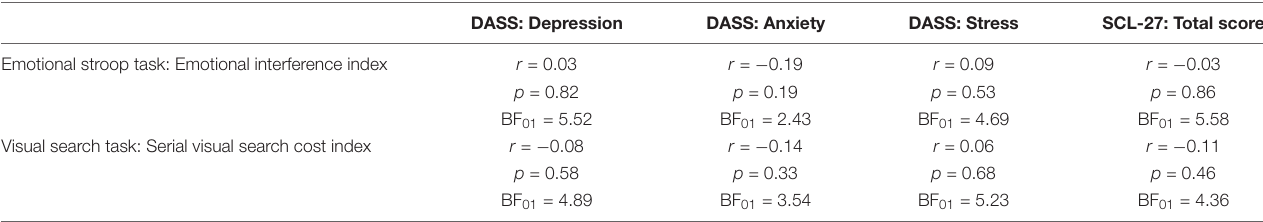
TABLE 6 | Frequentist and Bayesian correlation matrix between angular coefficients of behavioral tasks scores and wellbeing variables over time. DASS: Depression DASS: Anxiety DASS: Stress SCL-27: Total